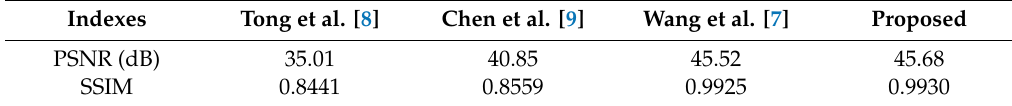
Table 2. Comparison of recovery performance for text addition attack on Lena image.